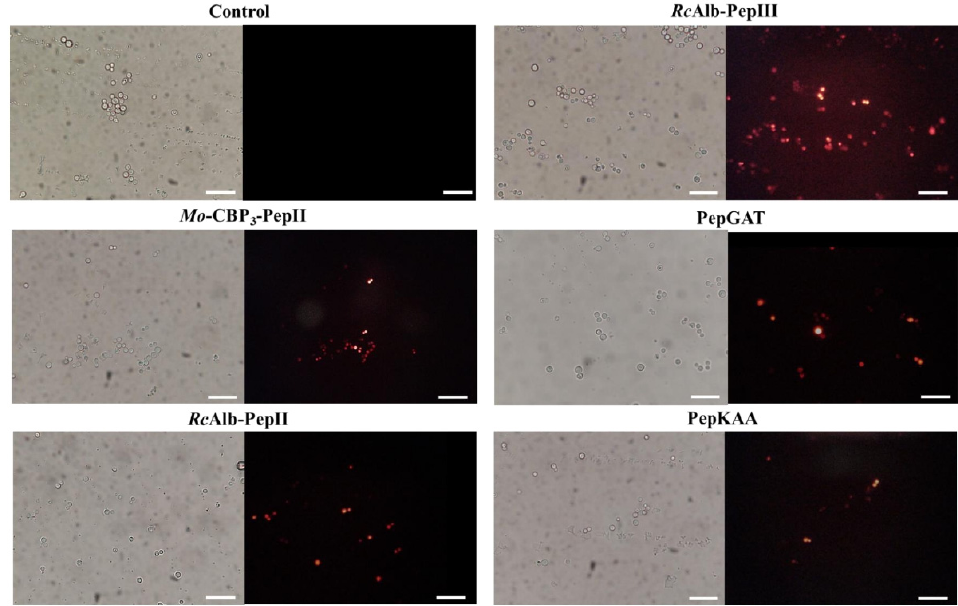
Figure 2. Fluorescence images showing membrane pore formation induced by Mo -CBP 3 -PepII, Rc Alb-PepII, Rc Alb-PepIII, PepGAT, and PepKAA, respectively, at 25, 0.04, 0.04, 0.04, and 0.04 µg mL − 1 . Detection of red fluorescence in the peptide-treated cells indicates that PI was internalized. In control (DMSO-NaCl), the absence of PI fluorescence indicates the integrity of the cell membrane. Bars: 100 µm.